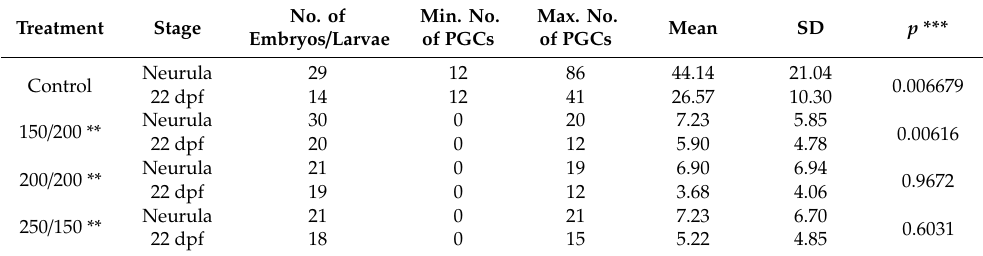
Table 1. Di ff erent concentrations of sgRNAs and Cas9 protein.